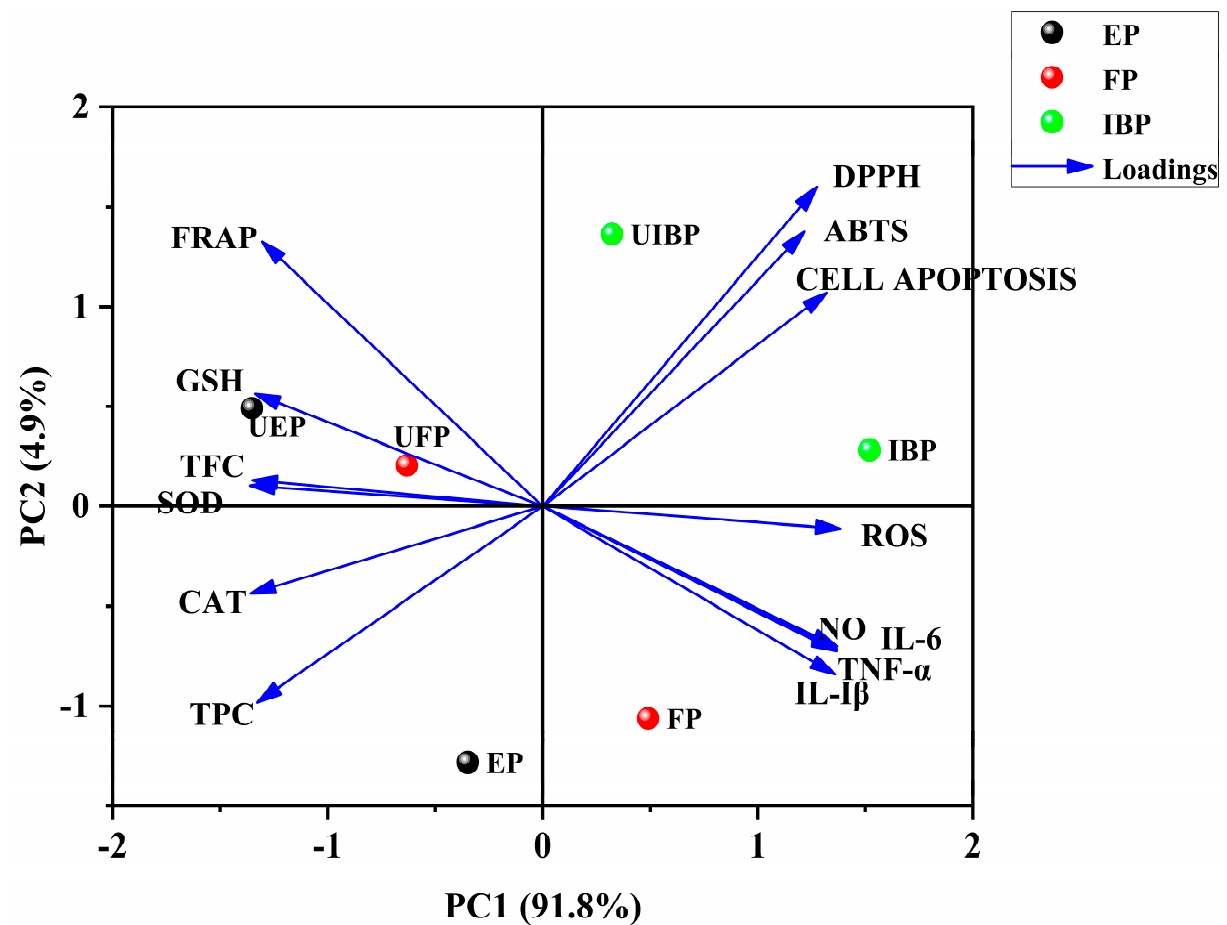
Figure 6. PCA analysis on TPC, TFC, antioxidant activities, cytoprotective effects, and anti-inflammatory activities. FP and UFP: free phenolic fraction from normal or UHHP-pretreated White Que Zui tea (WQT); EP and UEP: esterified phenolic fraction from normal or UHHP-pretreated WQT; IBP and UIBP: insoluble-bound phenolic fraction from normal or UHHP-pretreated WQT.